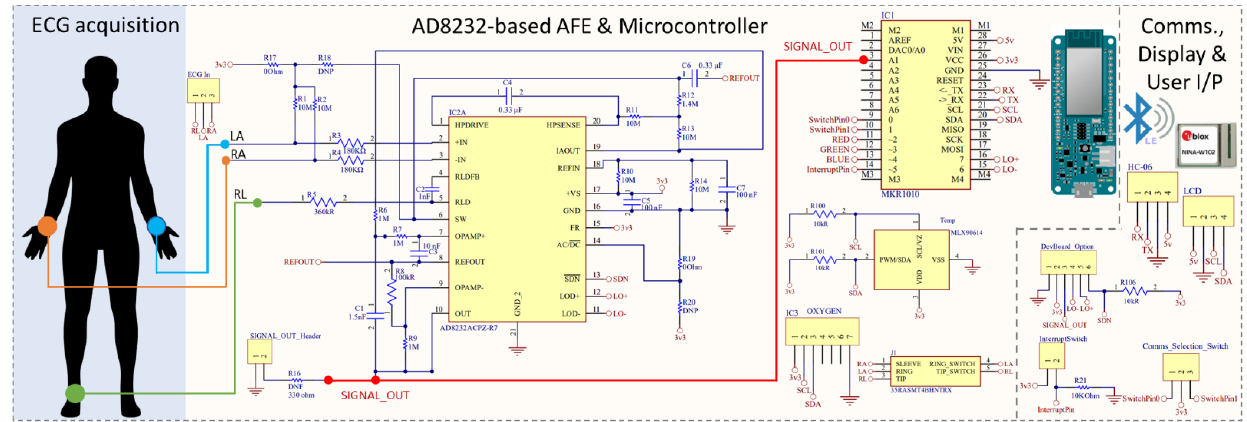
Figure 1. Custom-built, end-to-end ECG capturing system. The main components of the prototype are the AD8232-based AFE, temperature sensor (MLX90614), SpO2 sensor (MAX30100), and the Arduino MKR1010. The communication and display options are provided by the OLED and classic BT. The entire system is powered by a 3.7 V rechargeable Li battery.